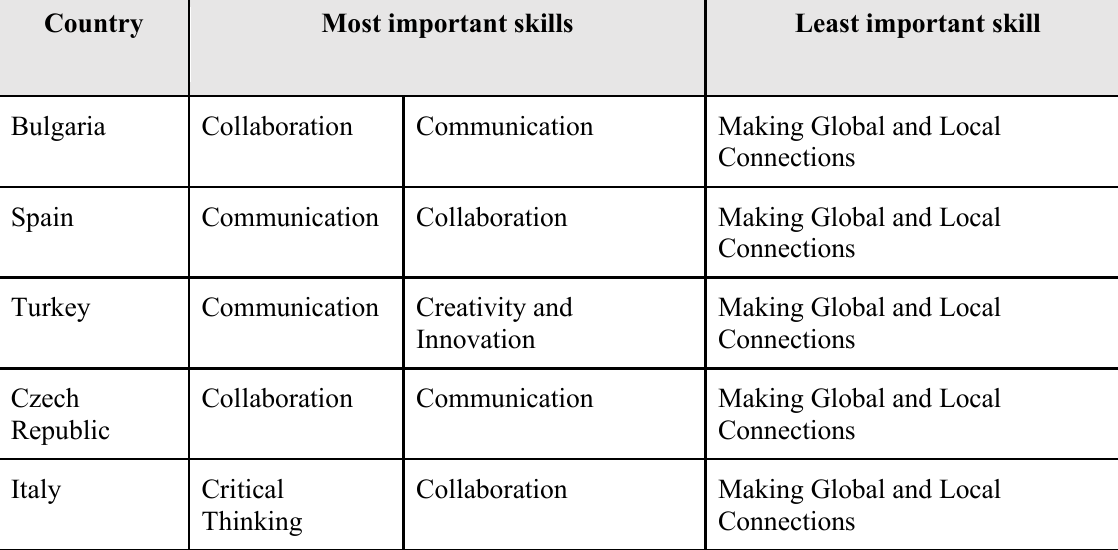
TABLE 1. MOST AND LEAST IMPORTANT SKILLS BASED ON INTERVIEWS Country Most important skills Least important skill